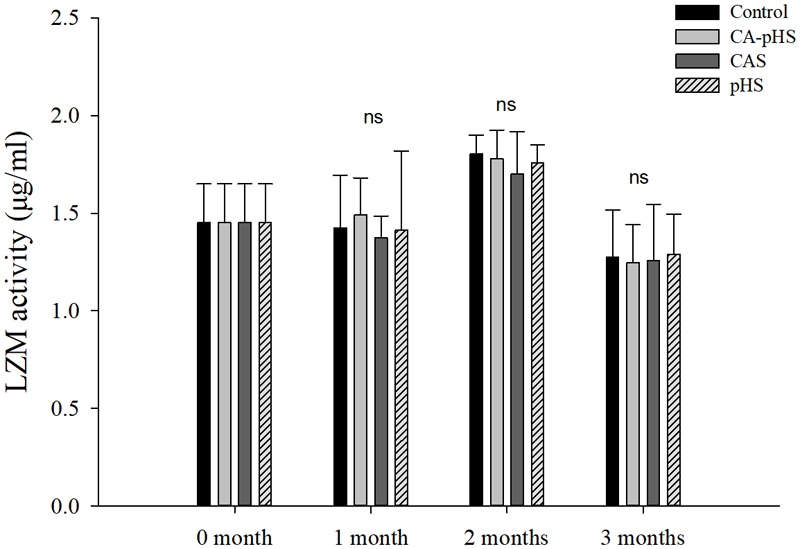
Juvenile of S. constricta lysozyme (LZM) activity levels in the long-term toxicity test. Bars (mean ± SE, n = 3) with different letters denote significant differences (p < 0.05) among the four groups in each month. The letters “ns” indicate insignificant difference among the four groups in each month.